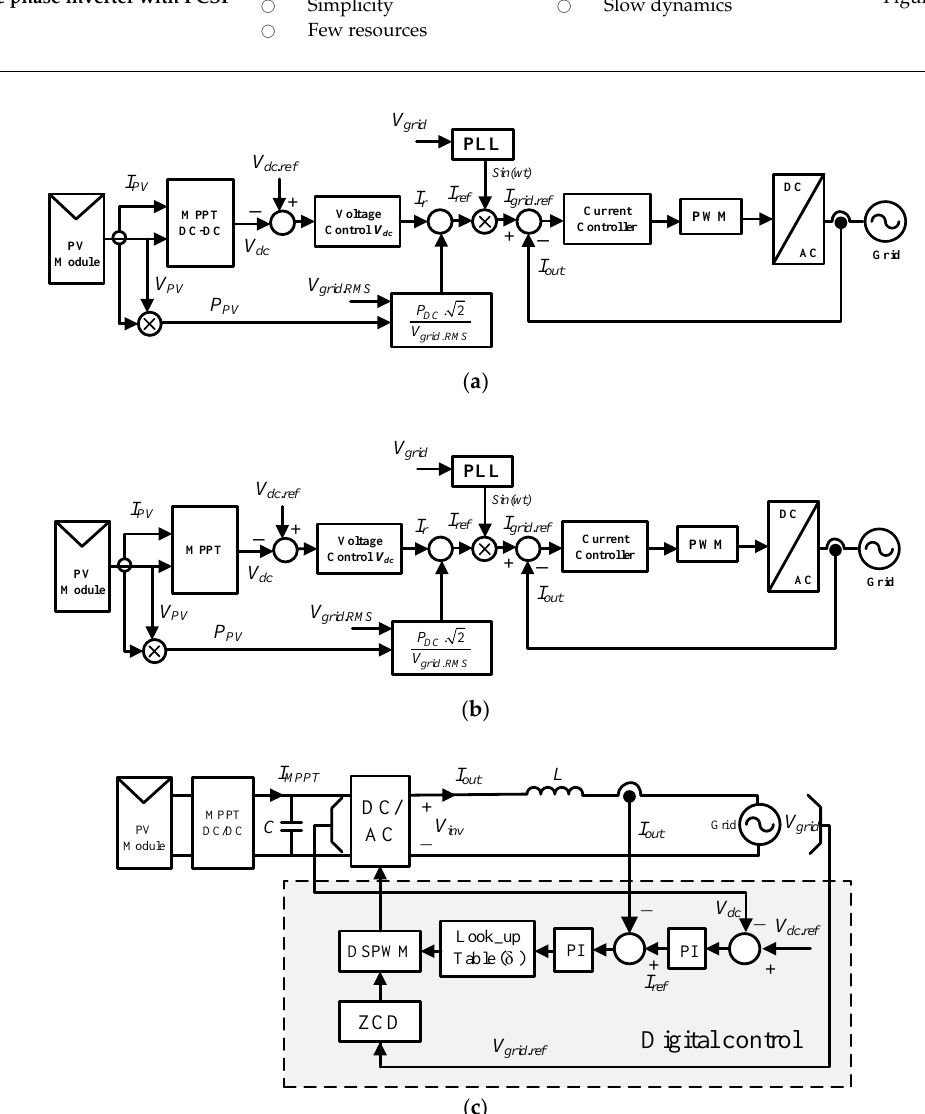
Figure 24. Configurations for single-phase inverters (a) DC/DC converter based single phase inverter ; (b) Single phase inverter without DC/DC converter ; (c) Single phase inverter with PCSP .